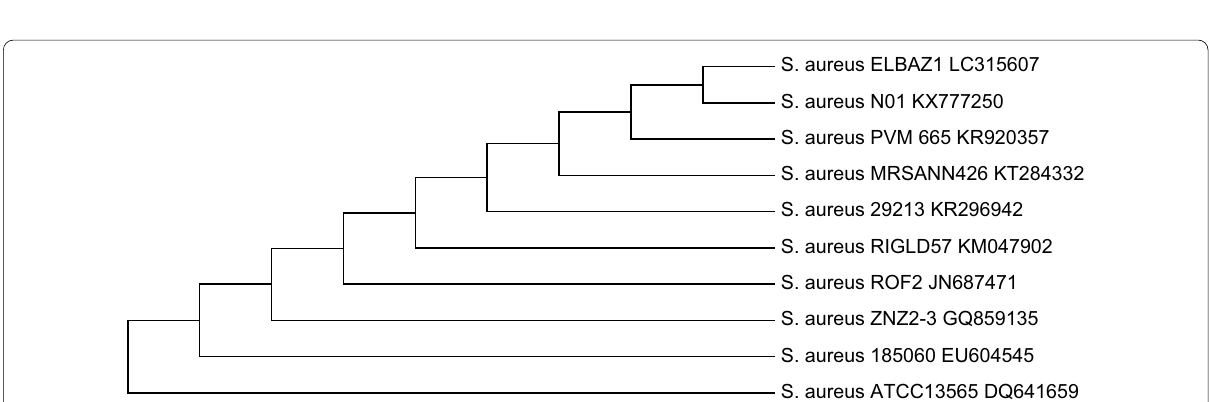
Fig. 5 The minimum evolution distance analysis phylogenetic tree of SEA gene encoding S. aureus MF563554 compared with other strains of SEA encoding gene available in